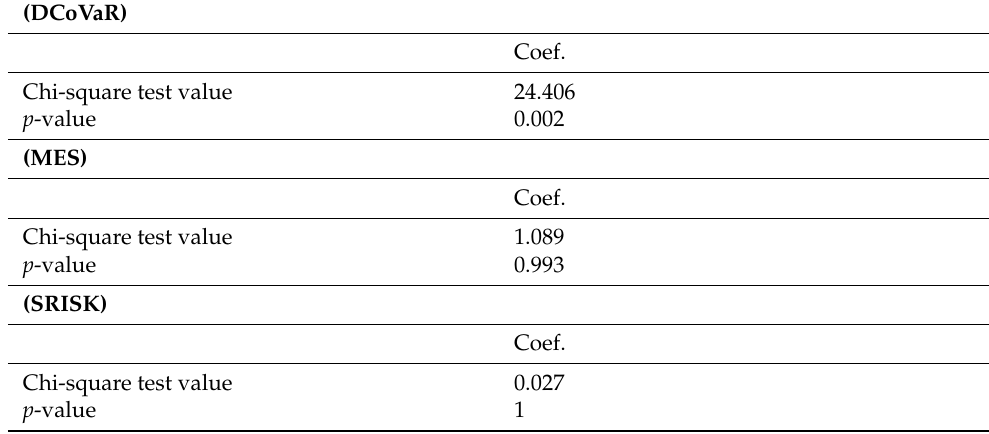
Table 10. Hausman specification test.